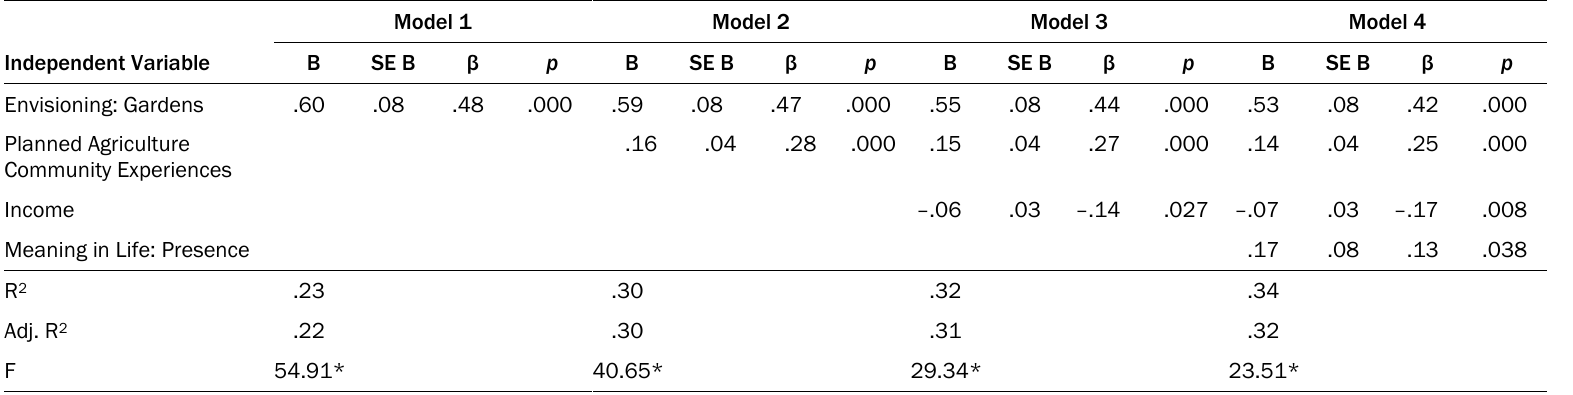
Table A5. Dependent Variable: Intrinsic Satisfaction From Community Food Model 1 Model 2 Model 3 Model